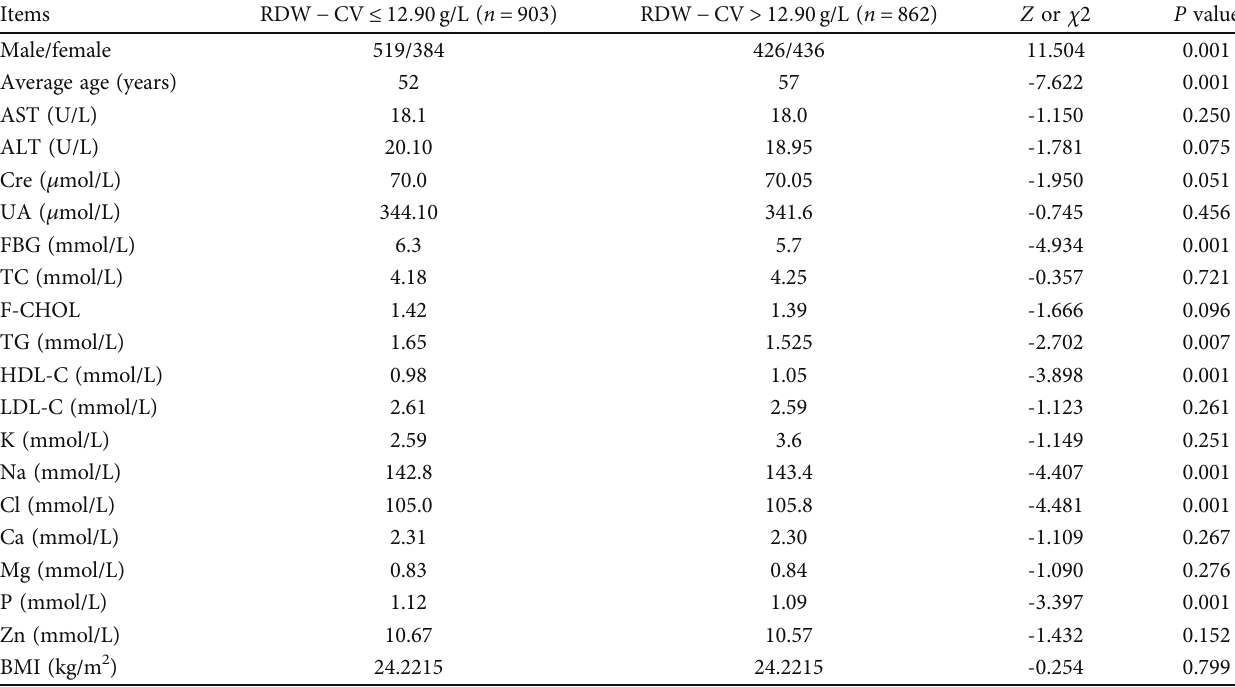
Table 4: Comparison of clinical data of patients in the RDW − CV ≤ 12 : 90 g/L and RDW − CV > 12 : 90 g/L